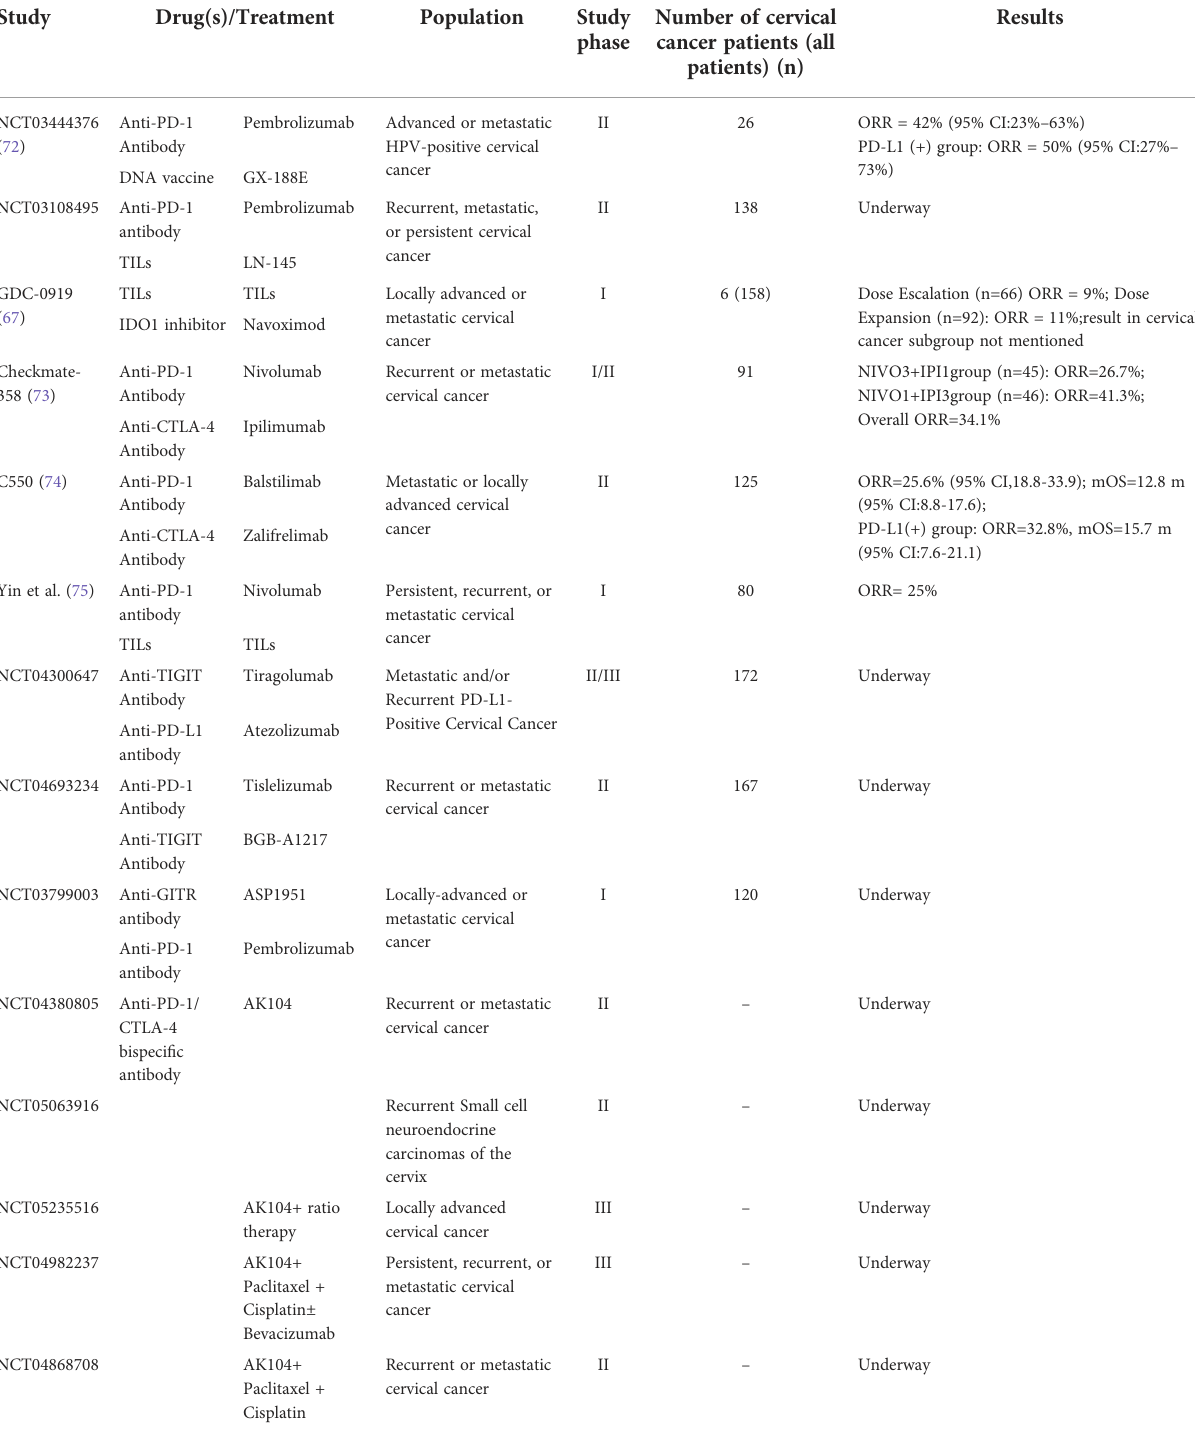
TABLE 2 Trials with combined use of two ICIs or ICIs with another